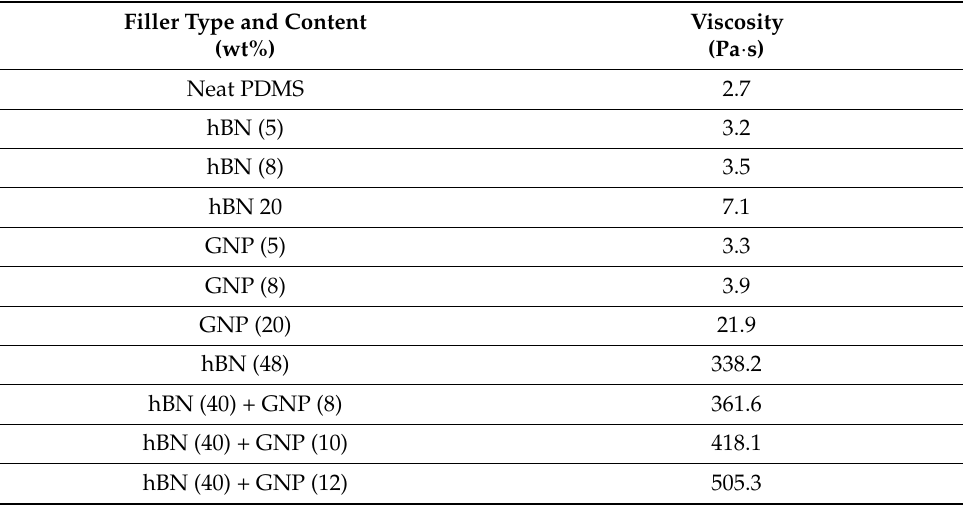
Figure 9. Viscosity values for different PDMS-based samples with hBN and GNP fillers measured at RT and at 1 s −1 . Table 5. Viscosity values for PDMS-based samples with different GNP and hBN content, measured at 1 s −1 shear rate.